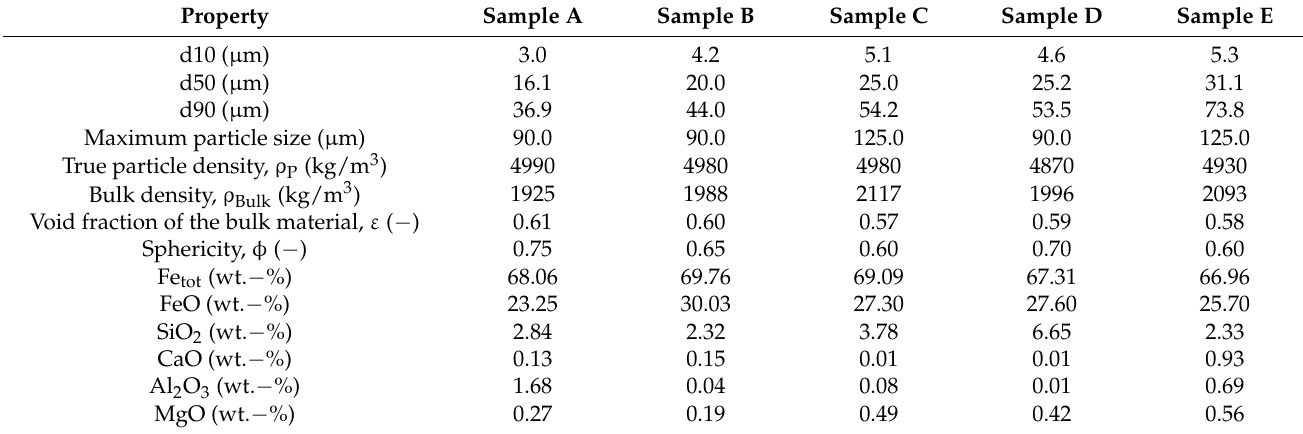
Table 1. Material properties relating to fluidization and the chemical analysis of some typical iron ore